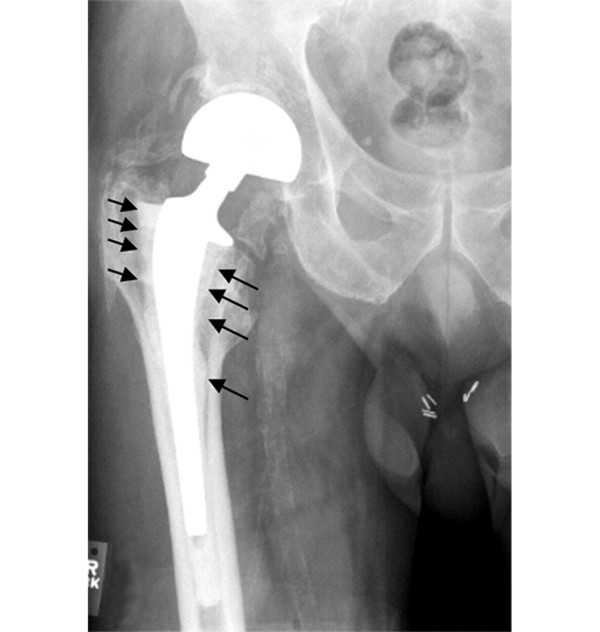
Preoperative radiograph from a study patient before revision hip arthroplasty for aseptic loosening. Arrows denote the area of extensive peri-implant osteolysis along the femoral shaft.